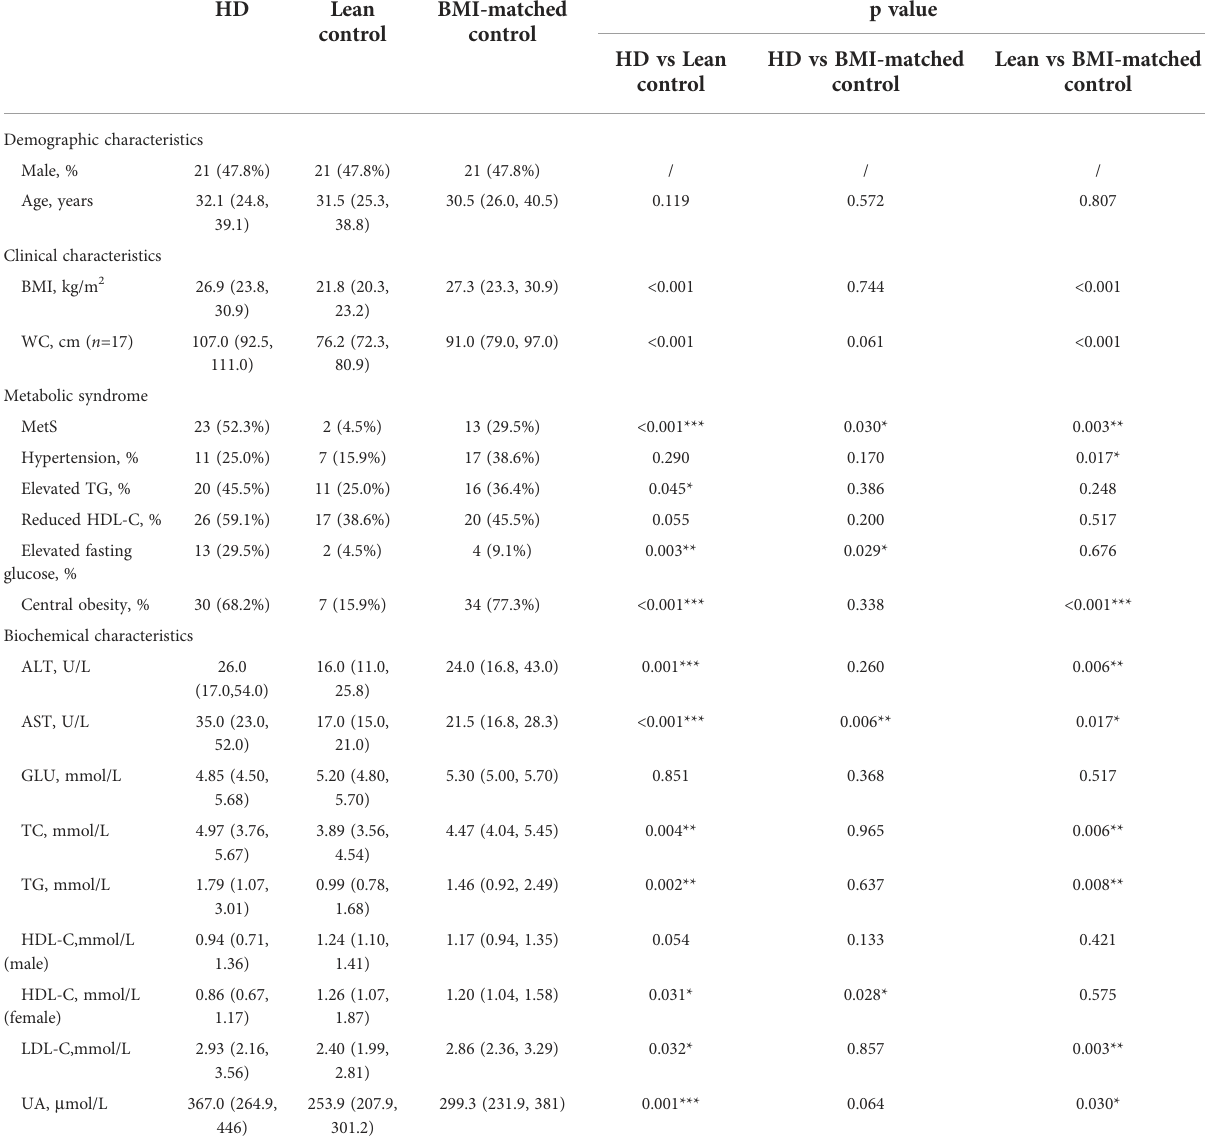
TABLE 6 Metabolic diseases and biochemical characteristics of adults with hypothalamic dysfunction in comparison with lean control and BMI- matched control ( n =44).